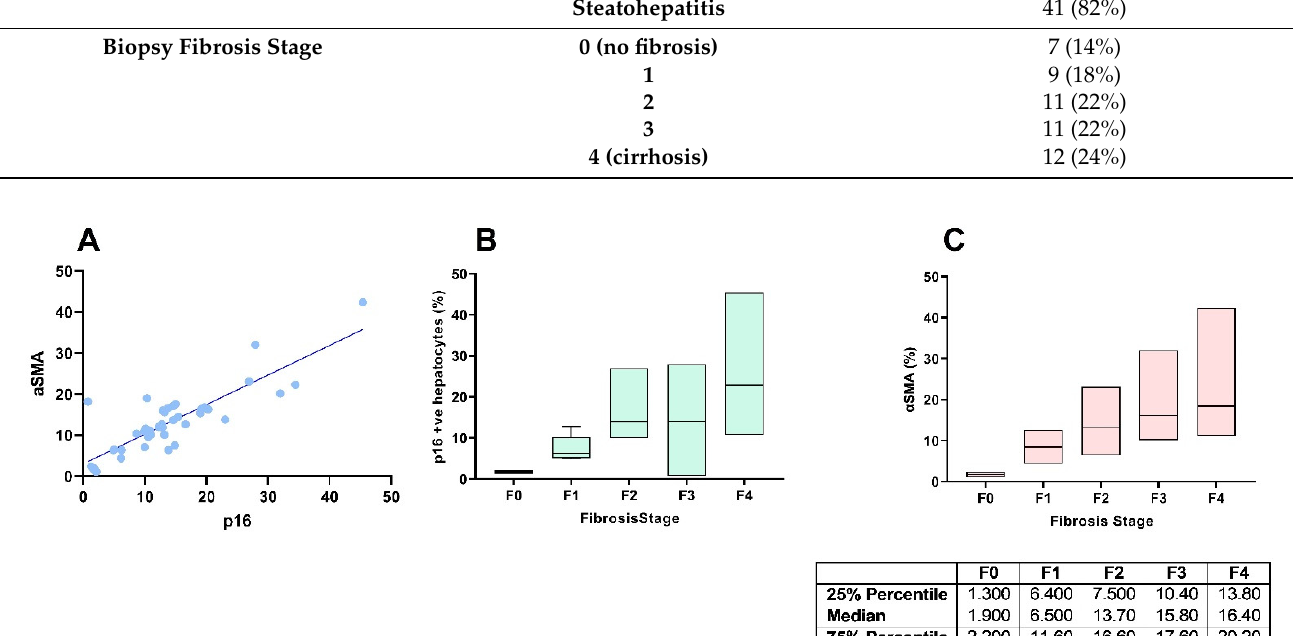
Figure 1. Associations between proportion of senescent hepatocyte (represented by positive p16 staining) and hepatic stellate cell activation (represented by α SMA expression) ( A ); proportion of senescent hepatocytes (represented by positive p16 staining) and liver fibrosis stage ( B ); hepatic stellate cell activation (represented by α SMA expression) and liver fibrosis stage ( C ).